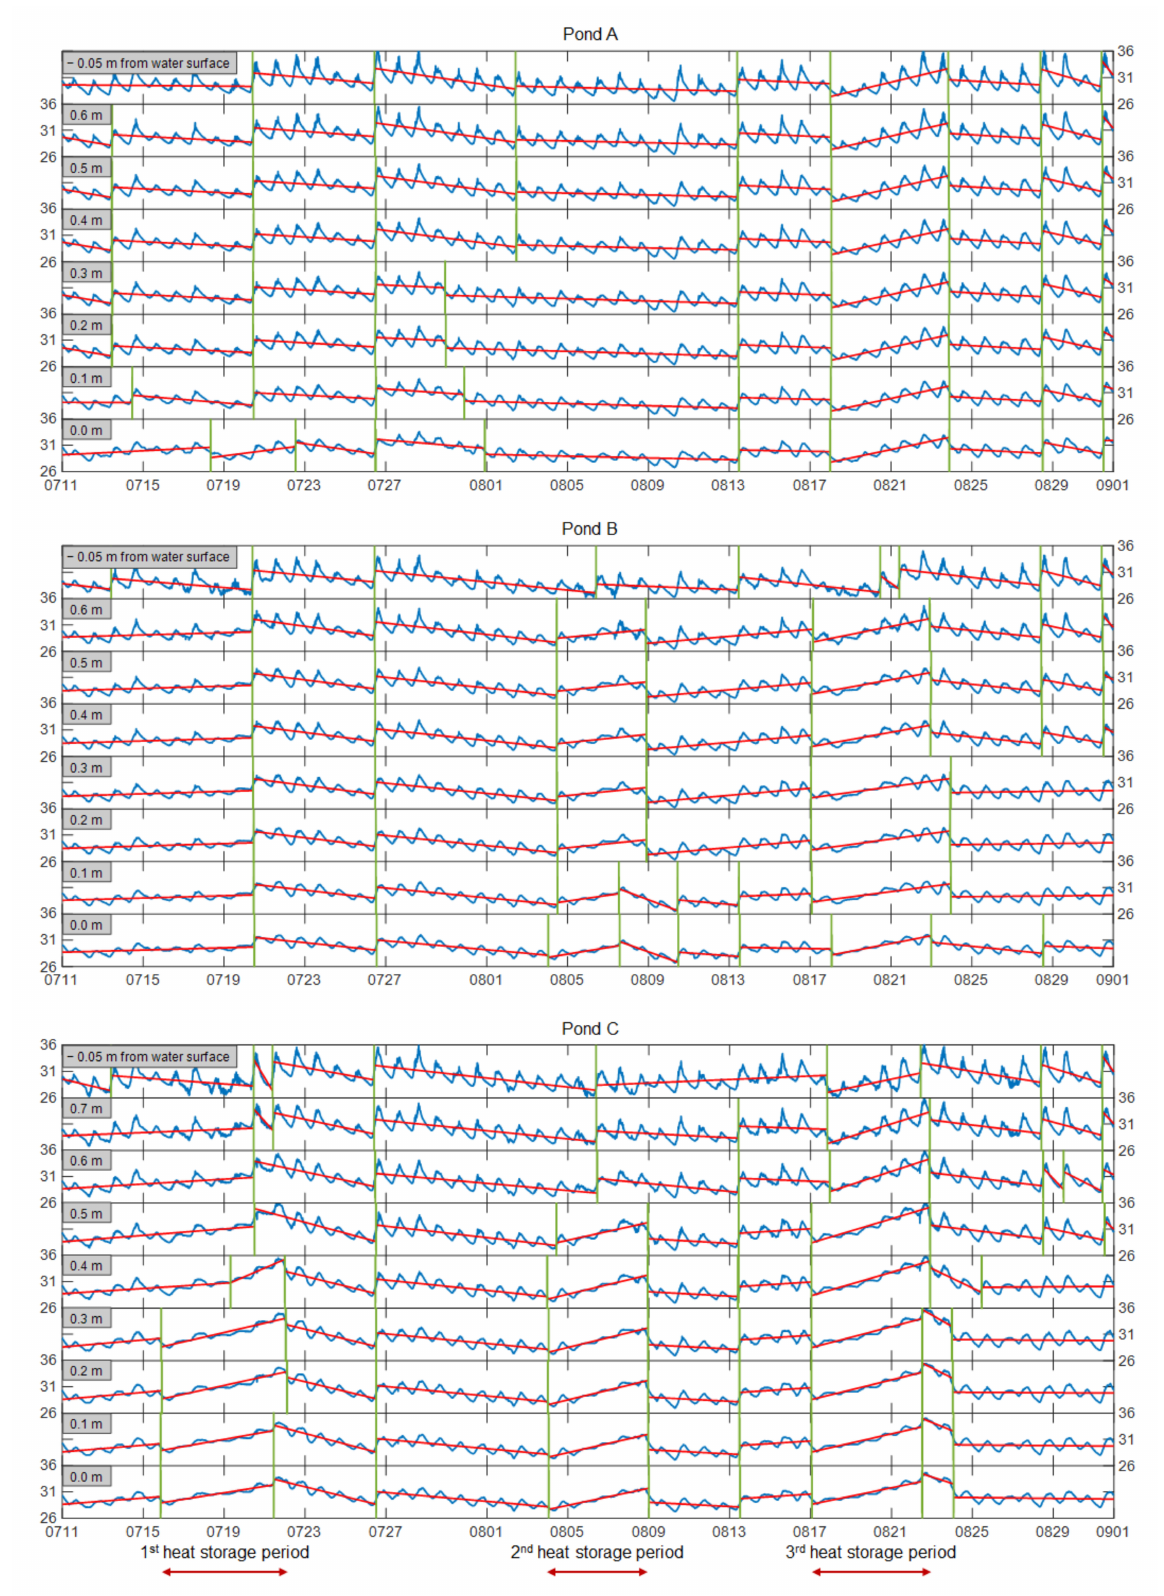
Figure 6. Results of change point analysis for water temperature data. Blue lines indicate water temperature variation, measured by fixed water temperature sensors inside ponds. Red lines indicate the slope of the detected segment. Green lines indicate the change points of water temperature